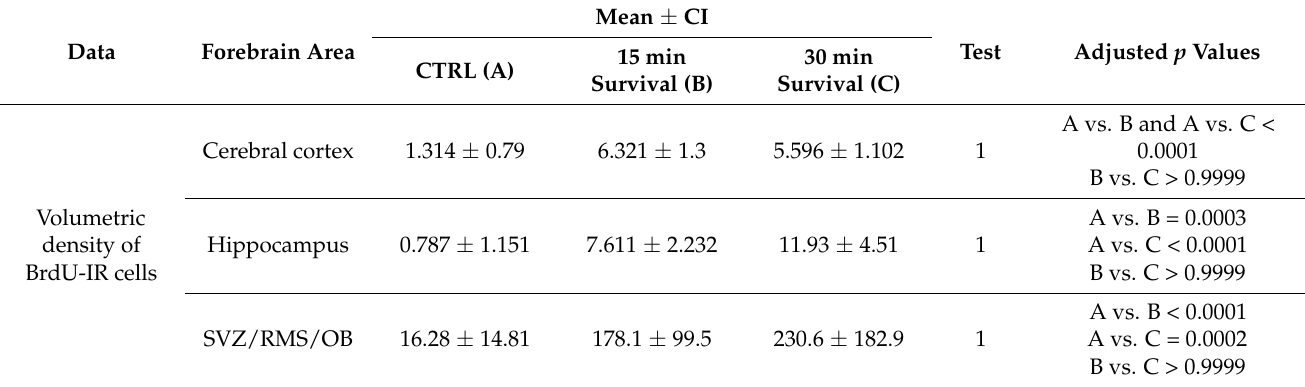
Table A5. Statistical analysis of volumetric densities and percentages of BrdU immunoreactive cells. Legend : 1 = Kruskal- Wallis and Dunn’s multiple comparisons test. See Figure 12 for graphs.